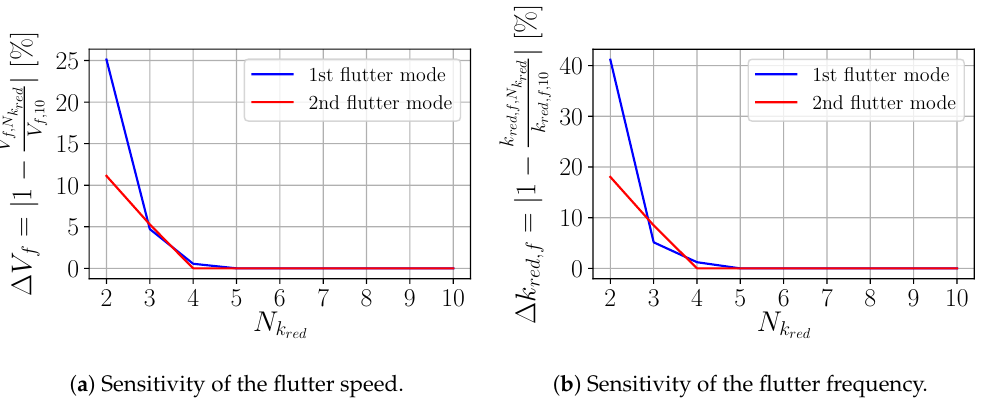
Figure 21. Sensitivity of the flutter limits with regard to the number of considered reduced